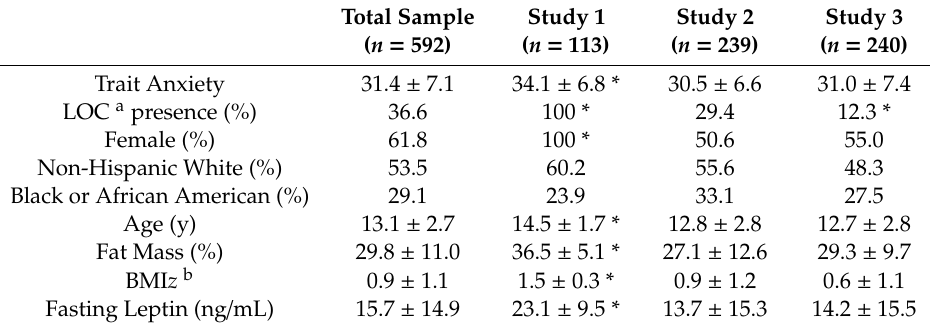
Table 1. Sample characteristics for total sample and by study.